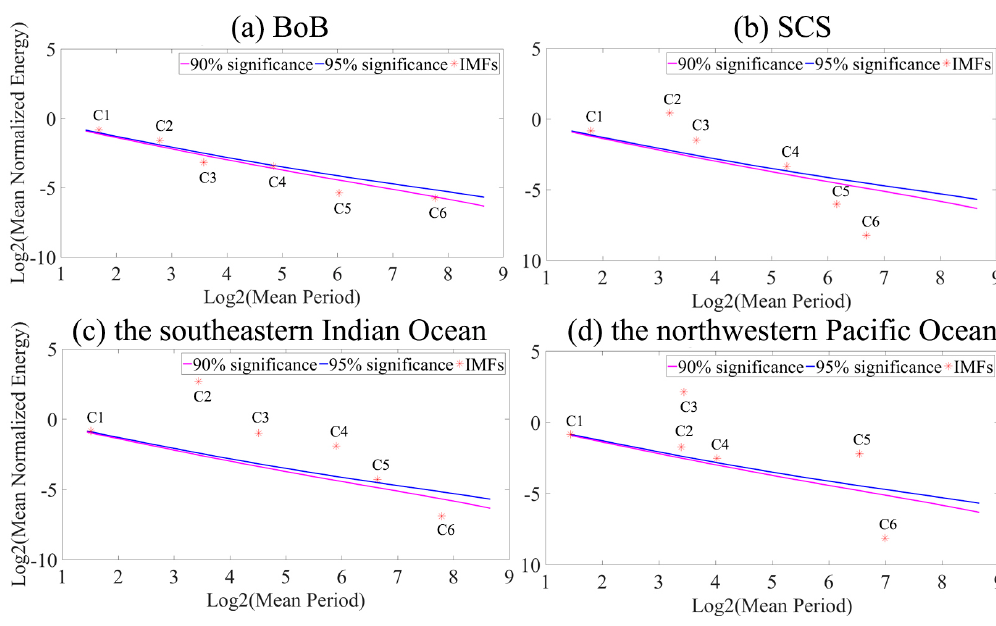
Figure 6. Significance tests of IMFs in the ( a ) Bay of Bengal (BoB), ( b ) South China Sea (SCS), ( c ) southeastern Indian Ocean, ( d ) northwestern Pacific Ocean. Statistically significant IMFs were placed above the diagonal lines for the 95% (blue line) and 90% significance levels (magenta line).